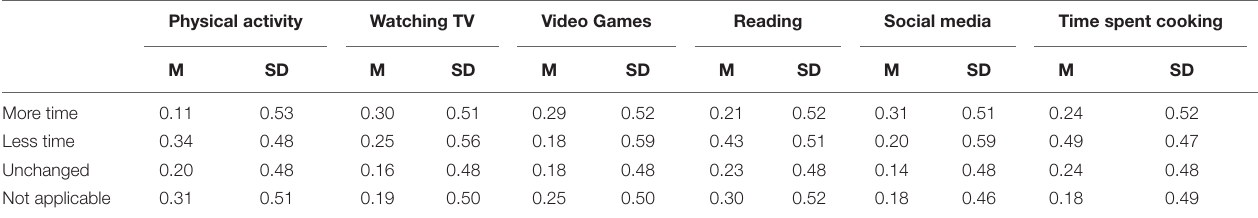
TABLE 5 | Mean values of the experienced changes in subjective psychological strain among persons with increases, decreases and no changes in the frequency of the performance of different types of activities. Physical activity Watching TV